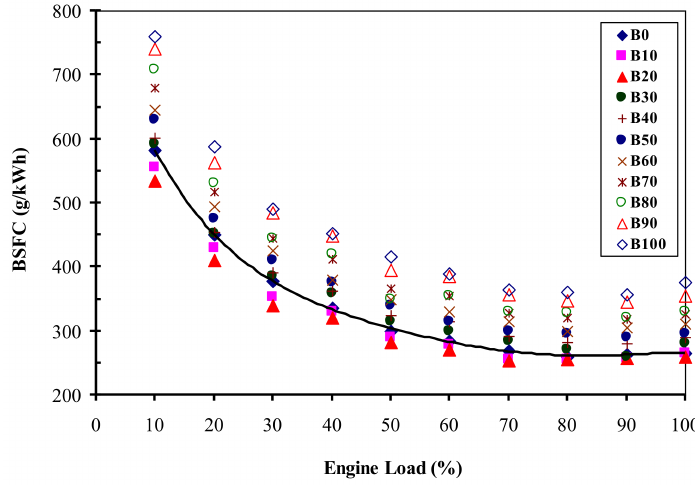
Figure 3. Brake specific fuel